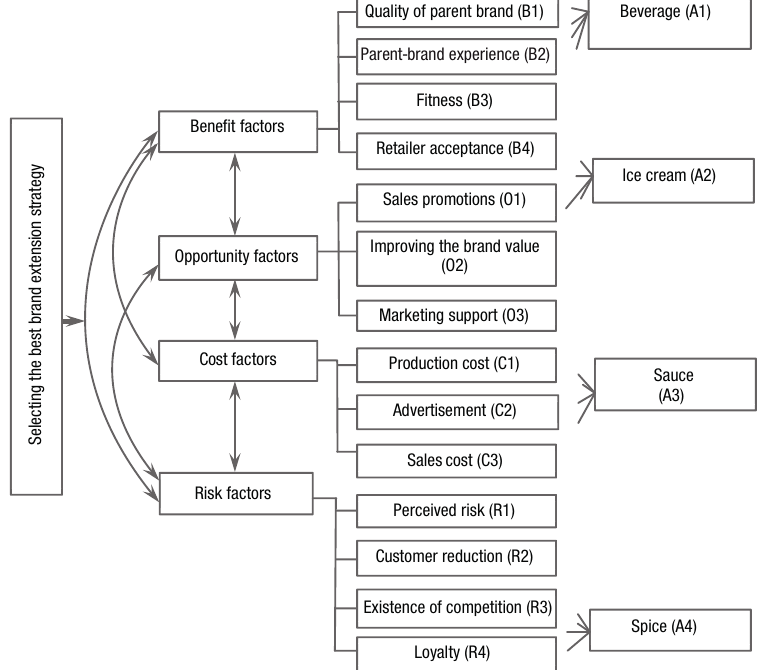
Fig. 4. Structure of the brand extension